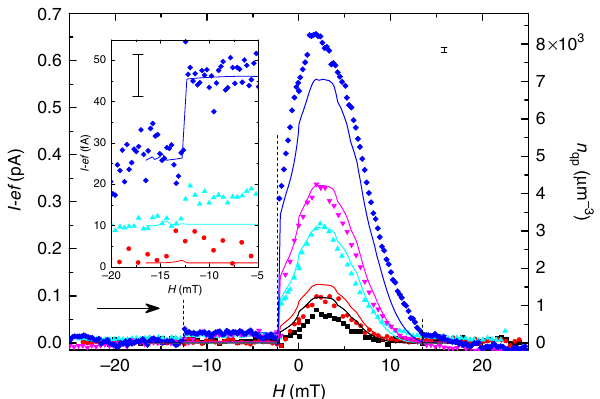
Figure 4 | Excess pumping current versus magnetic field. The excess current I (cid:3) ef at the first plateau for the driving frequencies 0.5MHz (black), 1MHz (red), 5MHz (cyan), 10MHz (violet), and 30MHz (blue) with the maximum electronic temperature at B ( H ) ¼ 0 of 274, 286, 320, 337 and 369mK, respectively. Applied magnetic field H is swept from (cid:3) 25 to 25mT (the sweep direction is shown by a horizontal arrow). The vertical dashed lines show the expected values corresponding to the entrance of an extra vortex into the island (for H 4 0) and to the removal of one vortex ( H o 0). (inset) A close-up of the current for a field close to the expulsion of the second vortex. For better visibility, the data sets for different frequencies have been shifted vertically. The measurements were performed at the bias voltage V bias ¼ 100 m V, the gate offset n 0 0.5. In g ¼ all panels symbols (solid lines) correspond to the experimental data (theoretical model). The scale on the right side shows the QP density n qp near the junction. The experimental uncertainty is estimated from the noise of the amplifiers as B 10fA, shown as an error bar on both diffusion equation across the sample volume and over the